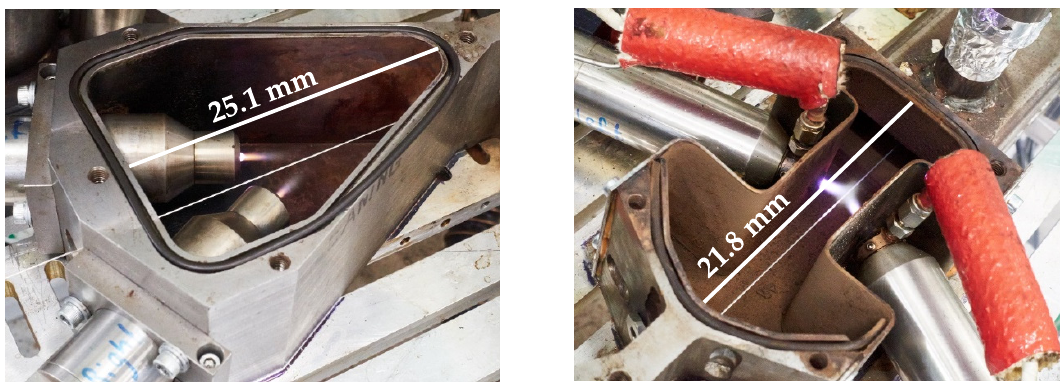
Figure 1. Left : decontamination chamber; right: plasma coating chamber.